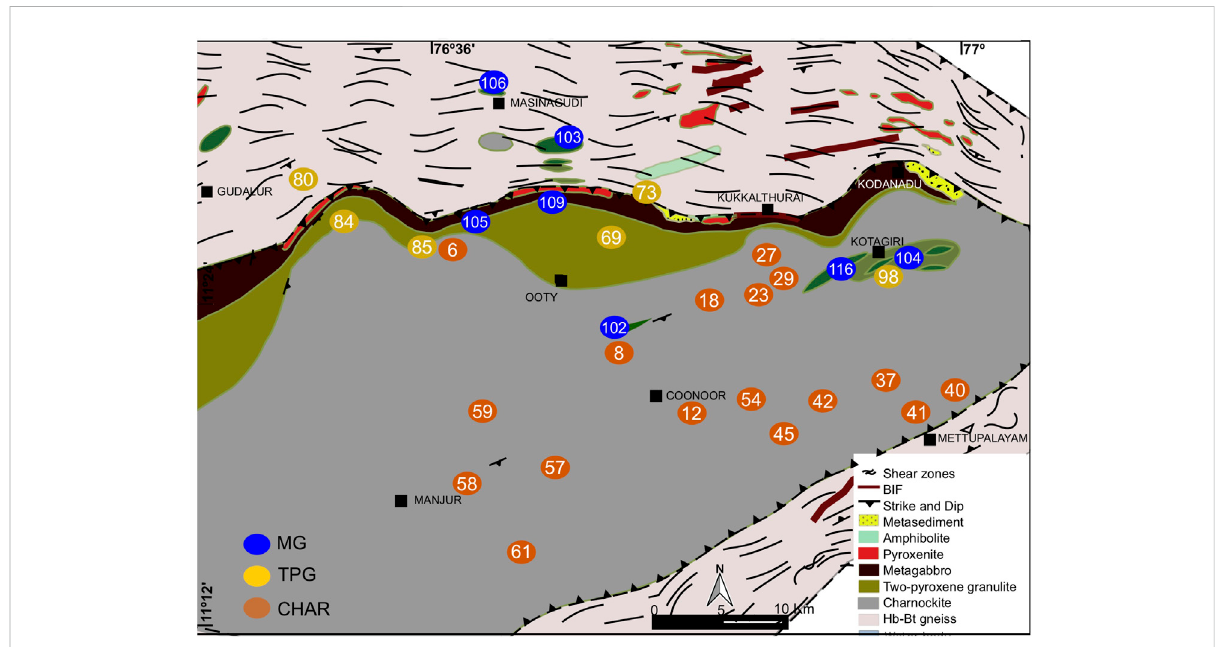
FIGURE 2 Geological map of the Nilgiri massif (modi fi ed after Samuel et al., 2021). Sample locations annotated by sample numbers are plotted on the map.The numbersarethesameas thoseusedinSamueletal.(2021),andarealsolistedinthe SupplementaryTable S1.CHAR-charnockitesamples, TPG- two-pyroxene granulite samples, and MG- metagabbro samples. This fi gure is created using QGIS 2.6.1 (https://www.qgis.org/en/site/) and modi fi ed using Inkscape version 0.92.2